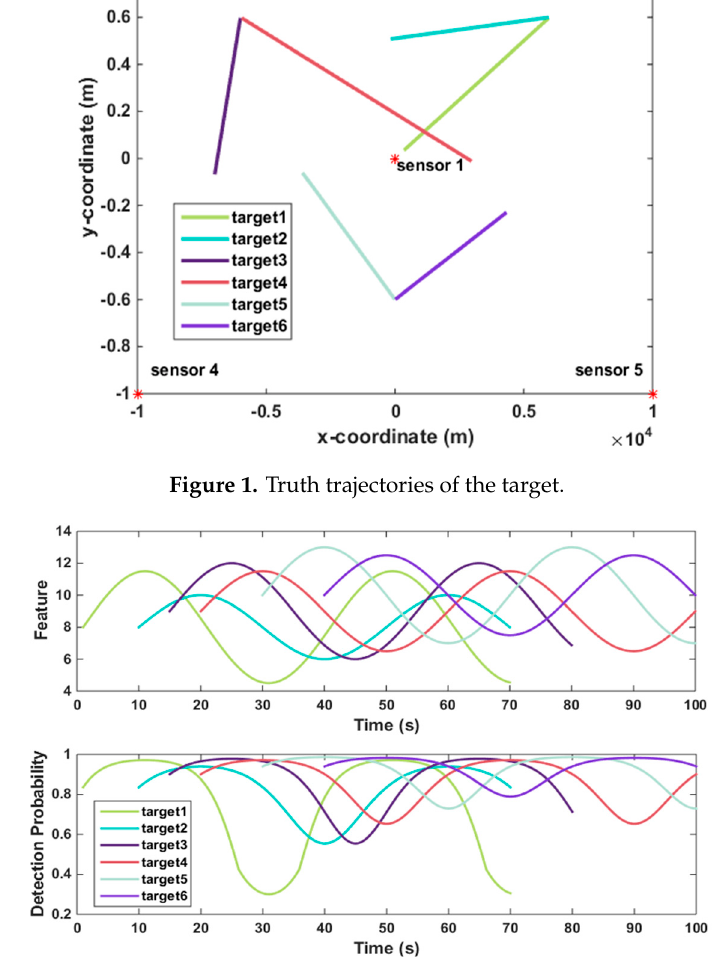
Figure 2. Target detection probability and the feature a .